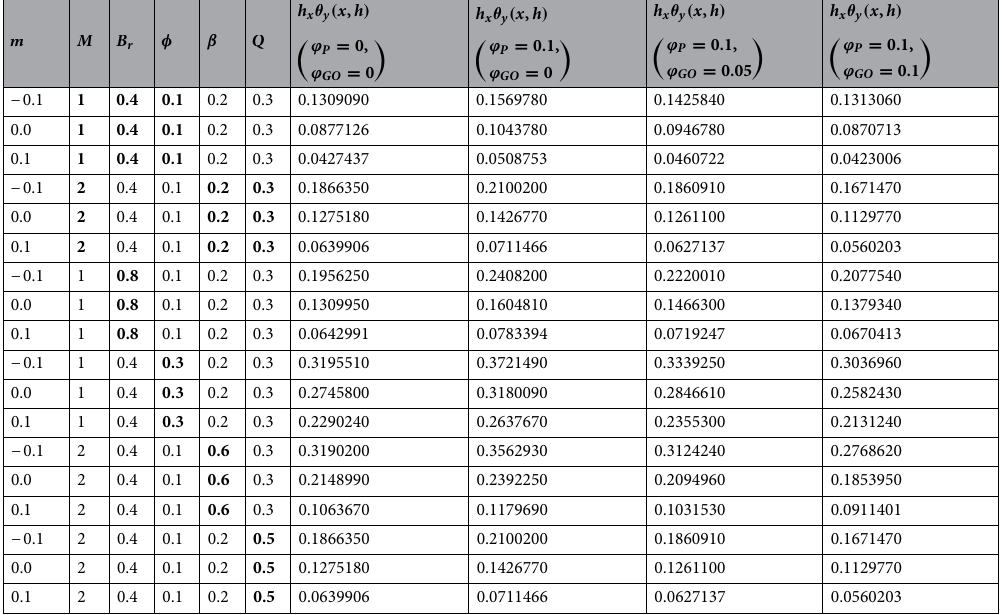
Table 6. Heat transfer rate z = ηθ y at wall h for water, P/water nano fluid , P-G0/water hybrid nano fluid varying non-uniformity parameter fixing m 0 = 3 ( sphere ) , x = 0.3, γ =